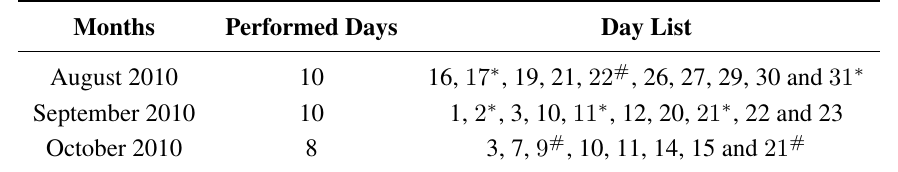
Table 2. Statistics of the measurement days of LiDAR scanning